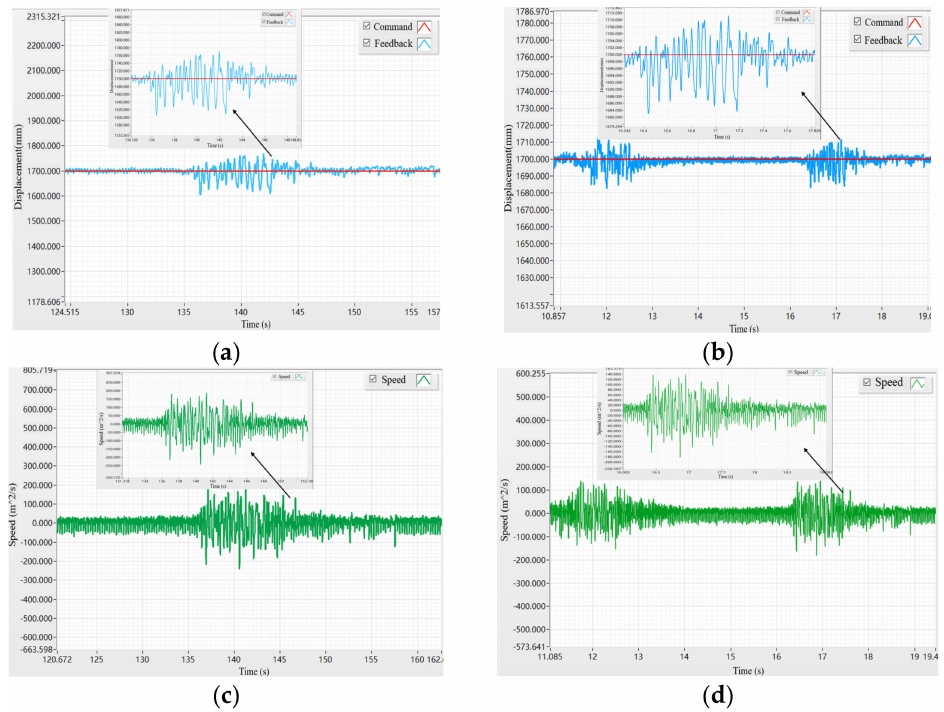
Figure 23. ( a ) Displacement curve under stable loading of PID; ( b ) Displacement curve under stable loading of ADRC; ( c ) Speed curve under stable loading of PID; ( d ) Speed curve under stable loading of